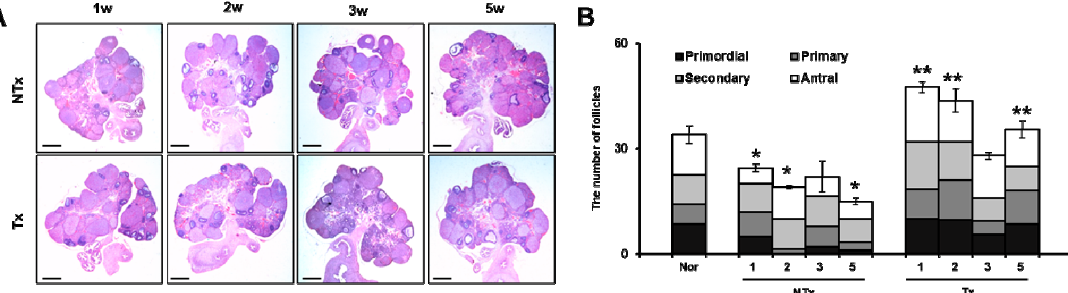
Figure 6. Effect of PD-MSCs transplantation on follicular development of the OVX rat model. Histopathological staining of ovary tissues was analyzed by hematoxylin and eosin staining in NTx and Tx (magnification × 10) ( A ). The numbers of total follicles and antral follicles were counted in NTx and Tx ( B and C ) The data are representative of three independent experiments and expressed as means ± SD. p < 0.05: *Normal vs. NTx, **NTx vs. Tx.